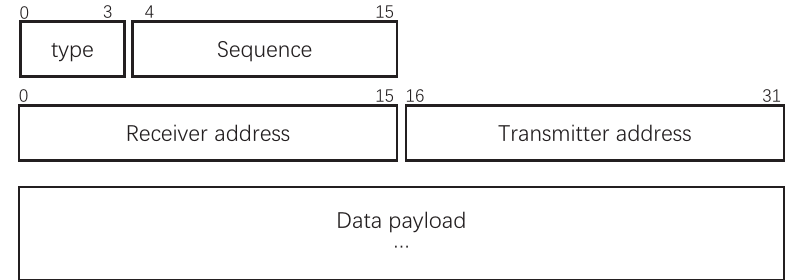
Figure 6. The packet